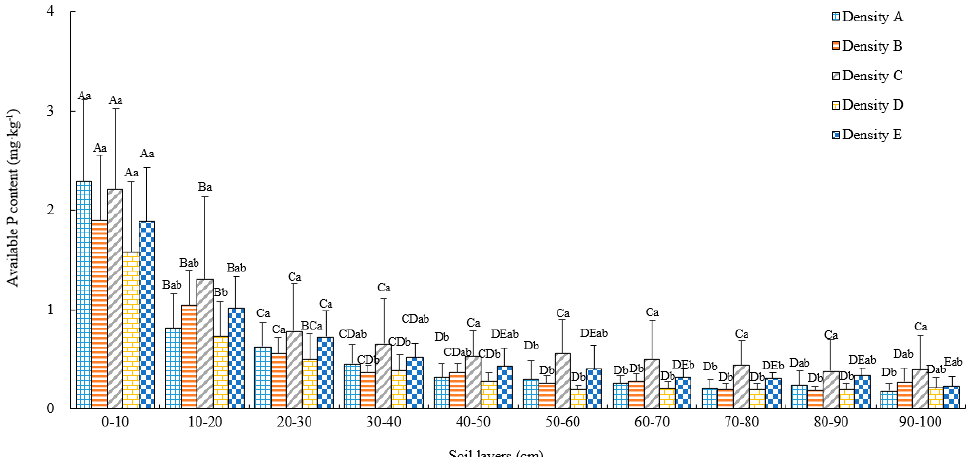
Figure 6. Soil available P in different layers under different stand enmities’ (mg·kg − 1 ). Note: different lowercase letters indicate significant differences among different densities at the 0.05 level, and different capital letters of the same density indicate significant differences among different soil layers at the 0.05 level.